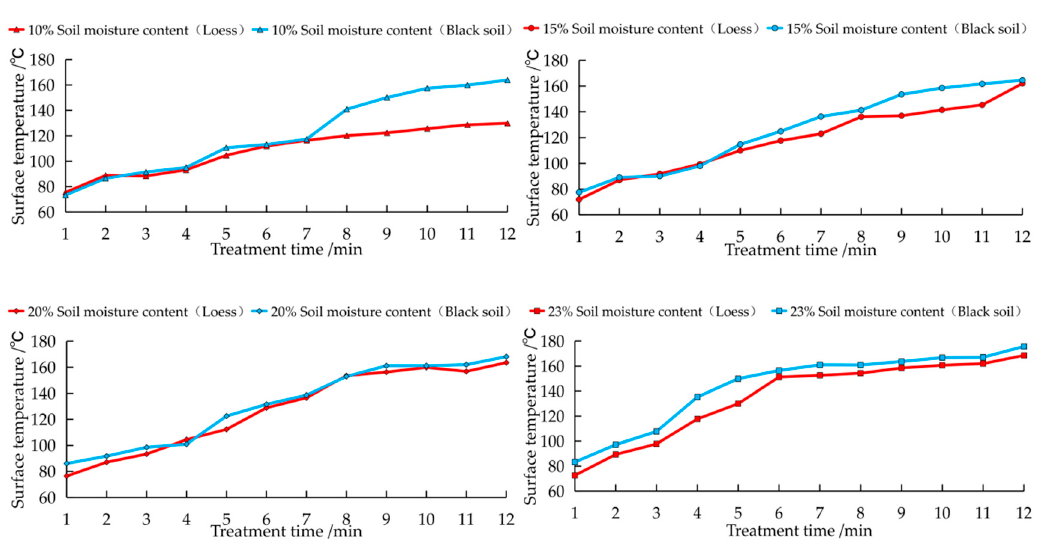
Figure 15. Comparison of surface temperature between loess and black soil.